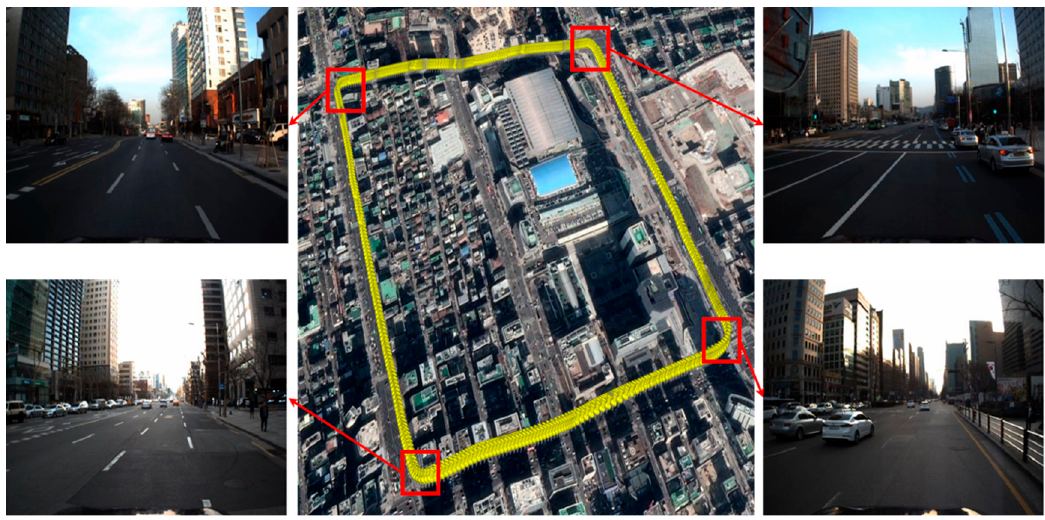
Figure 4. Map trajectory of an urban area.